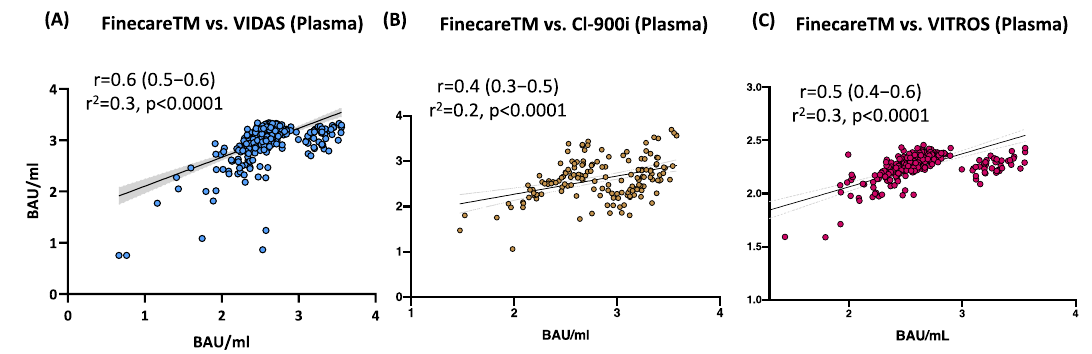
Figure 3. Correlation and linear regression analysis between FinecareTM and ( A ) VIDAS ® 3; ( B ) CL- 900i ® ; ( C ) VITROS ® . Pearson correlation coefficient ( r ), coefficient of determination (R 2 ) , and p -value are shown; n = 488. Table 2. Concordance assessment between FinecareTM and the three automated